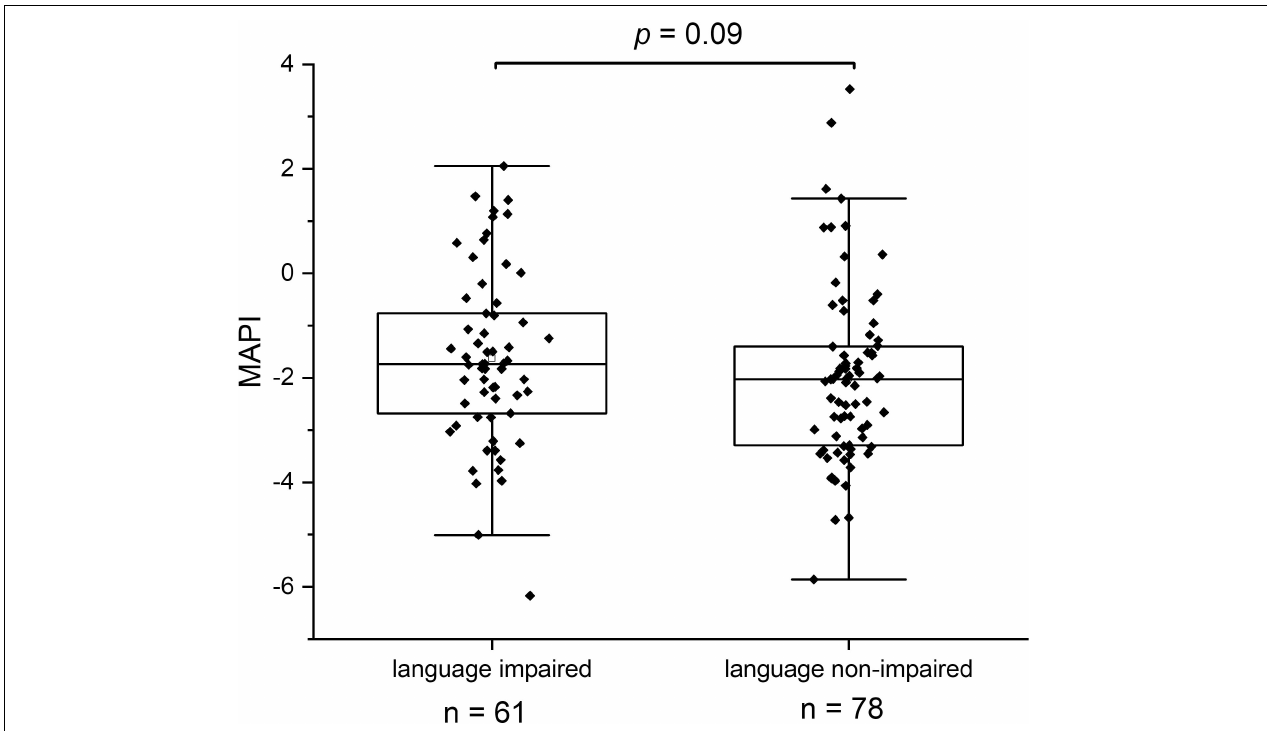
FIGURE 5 | The Metagenomic Aerotolerant Predominance Index (MAPI). The index is presented in box plots for the groups of language impaired ( n = 61) and language non-impaired children ( n =